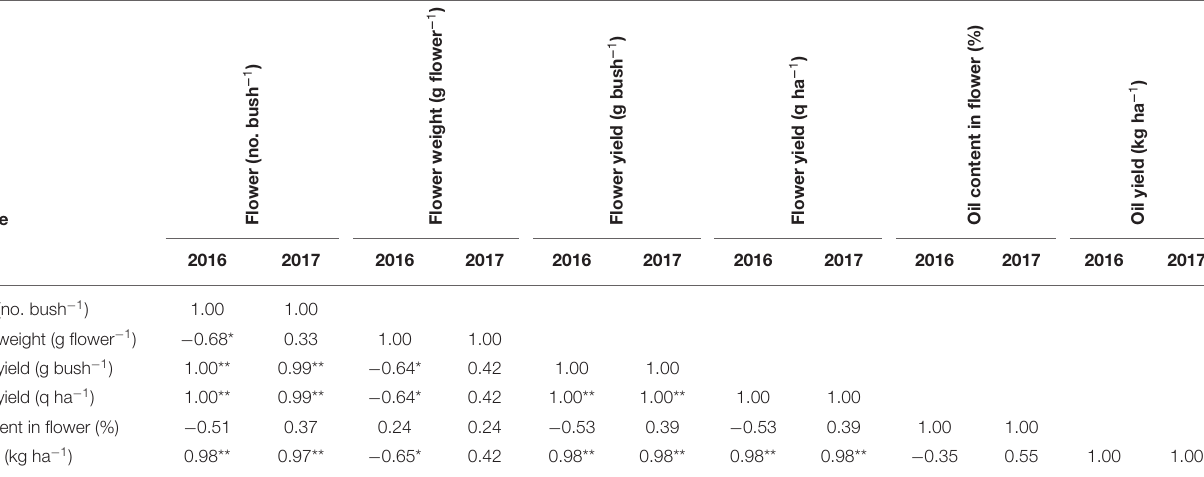
TABLE 2 | Correlation matrix among yield components and